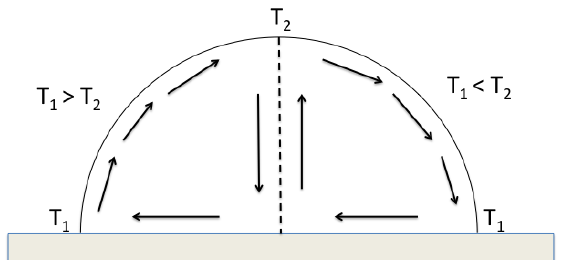
Figure 1. Direction of Marangoni driven flow for a constant gradient: ( Left ) T 1 > T 2 , evaporation; and ( Right ) T 1 < T 2 ,